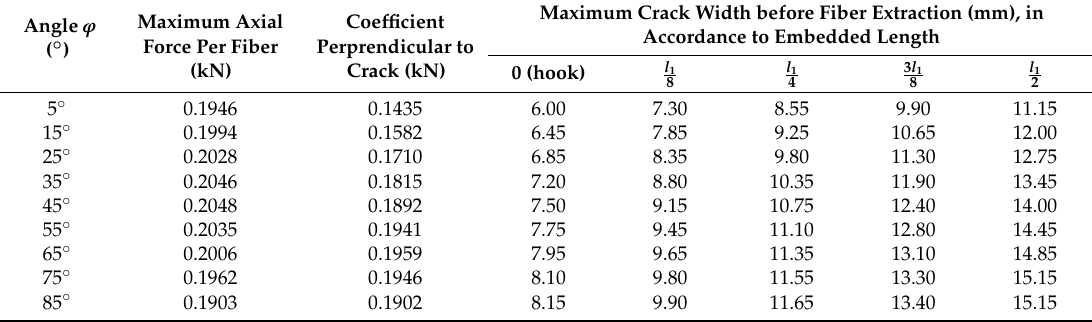
Table 4. Maximum axial force and force coefficient perpendicular to the crack, with the corresponding maximum crack opening before extraction, in accordance to embedded length.